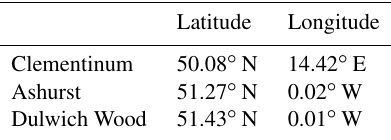
Table 6. Geographical coordinates of Clementinum, Ashurst, and Dulwich Wood – another place which Robert Snow used for his observations of the auroras that he reported in (Snow, 1842); this place is situated in southern